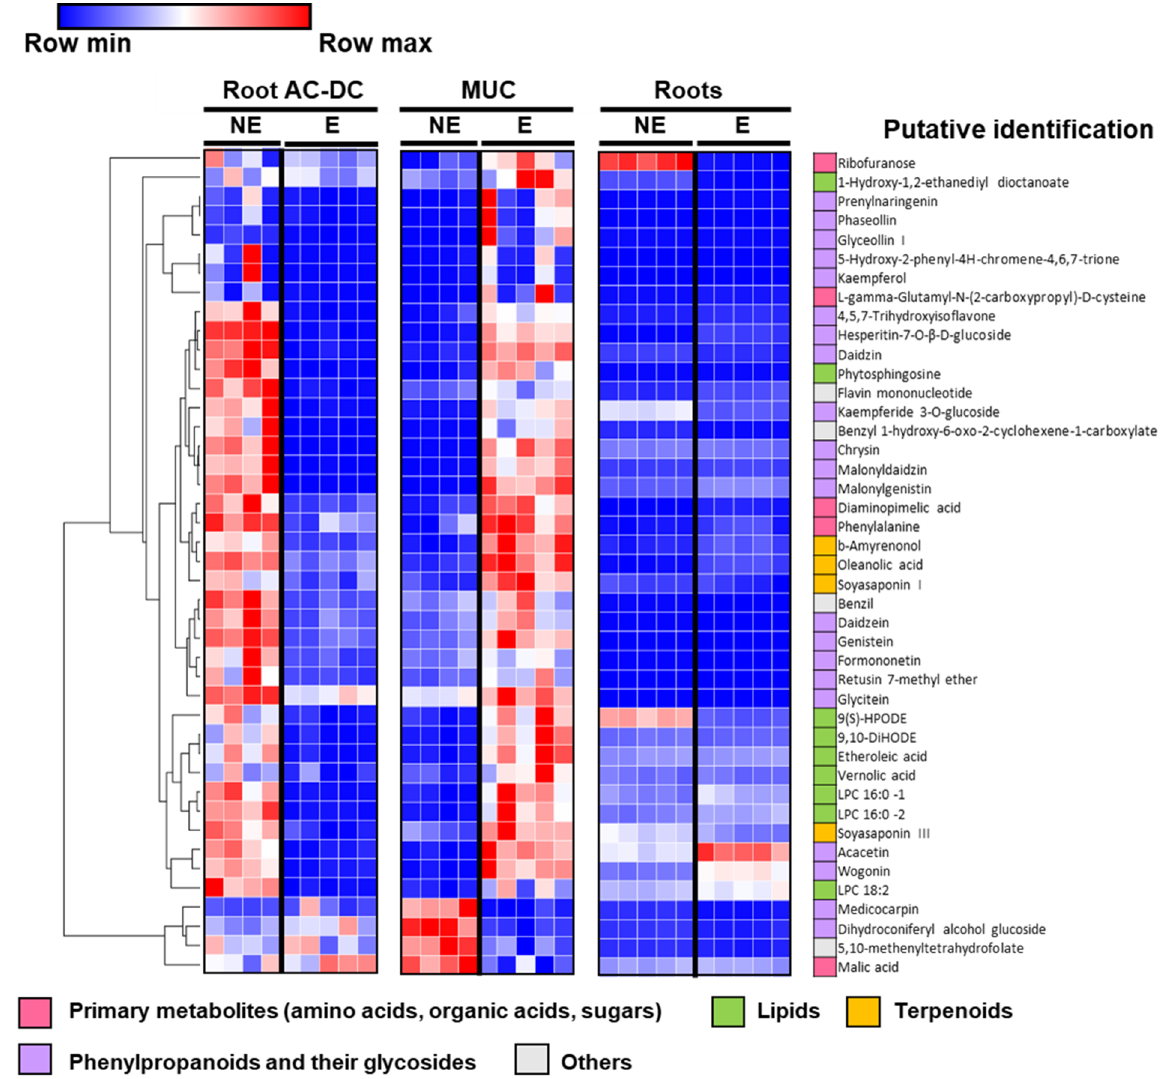
Figure 4. Heatmap of most-discriminative metabolites upon PEP-13 elicitation. Metabolite abun- dances were analyzed using UPLC–QTOF–MS–MS. Multivariate supervised classification OPLS-DA was established for each compartment (root AC-DC, MUC and roots) to discriminate between control (NE) and PEP-13 elicited (E) samples. The heatmap shows the peak abundance of all metabolites with a VIP > 2 in root AC-DC and Muc. The maximum abundance in each row is shown in red and the minimum in blue. MUC = mucilage; AC-DC = root-associated cap-derived cells; NE = non-elicited (control); PEP = PEP-13 elicited.